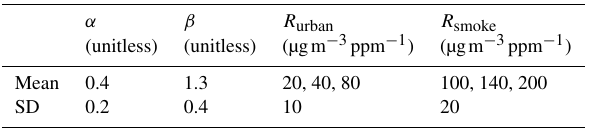
Table 4. Parameter values used in the Monte Carlo simulations. For the R urban and R smoke parameters, multiple mean values are considered.